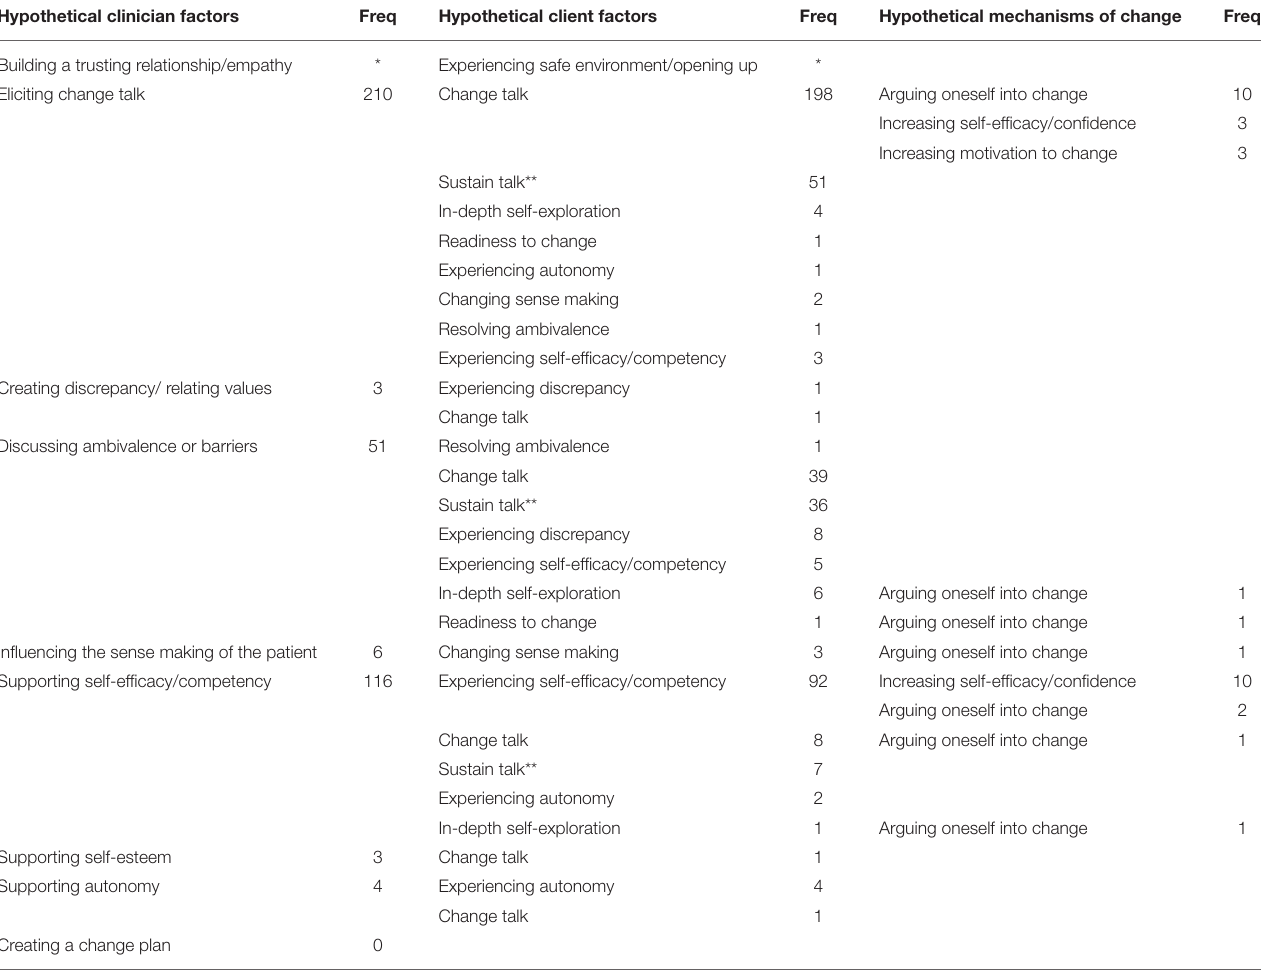
TABLE 7 | Hypothetical active ingredients (clinician factors and client factors), and mechanisms of change in 109 MI sessions. Hypothetical clinician